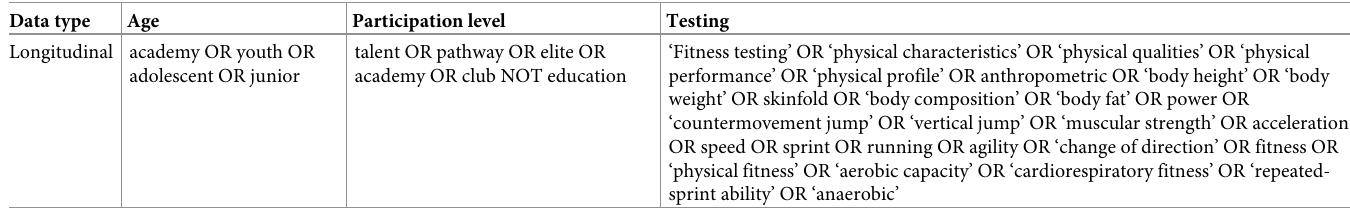
Table 1. Search terms used for systematic search of databases cased on data type, age, participation level and testing. Data